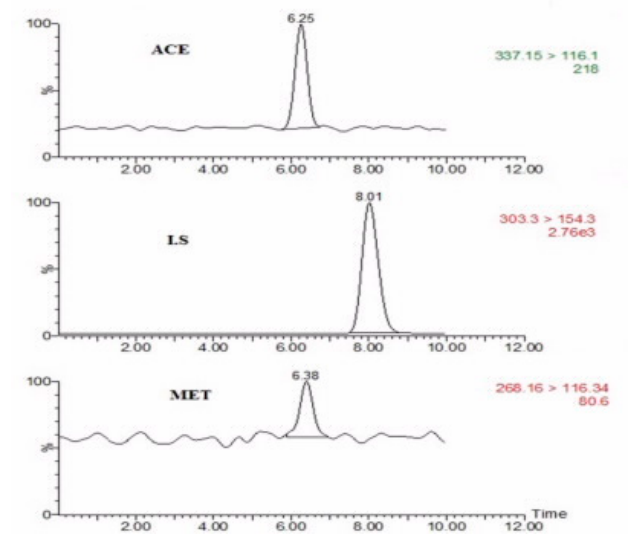
Figure 6. The chromatogram of lower limit of quantification (LLOQ) with internal standard.